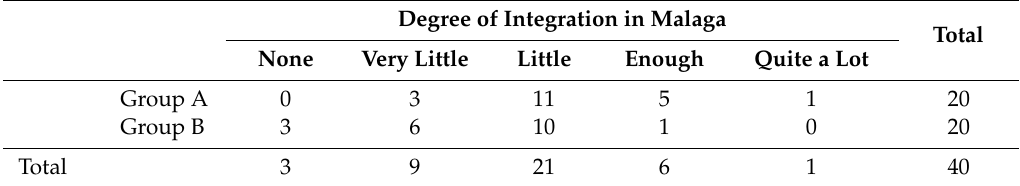
Table 8. Integration in Malaga society *.